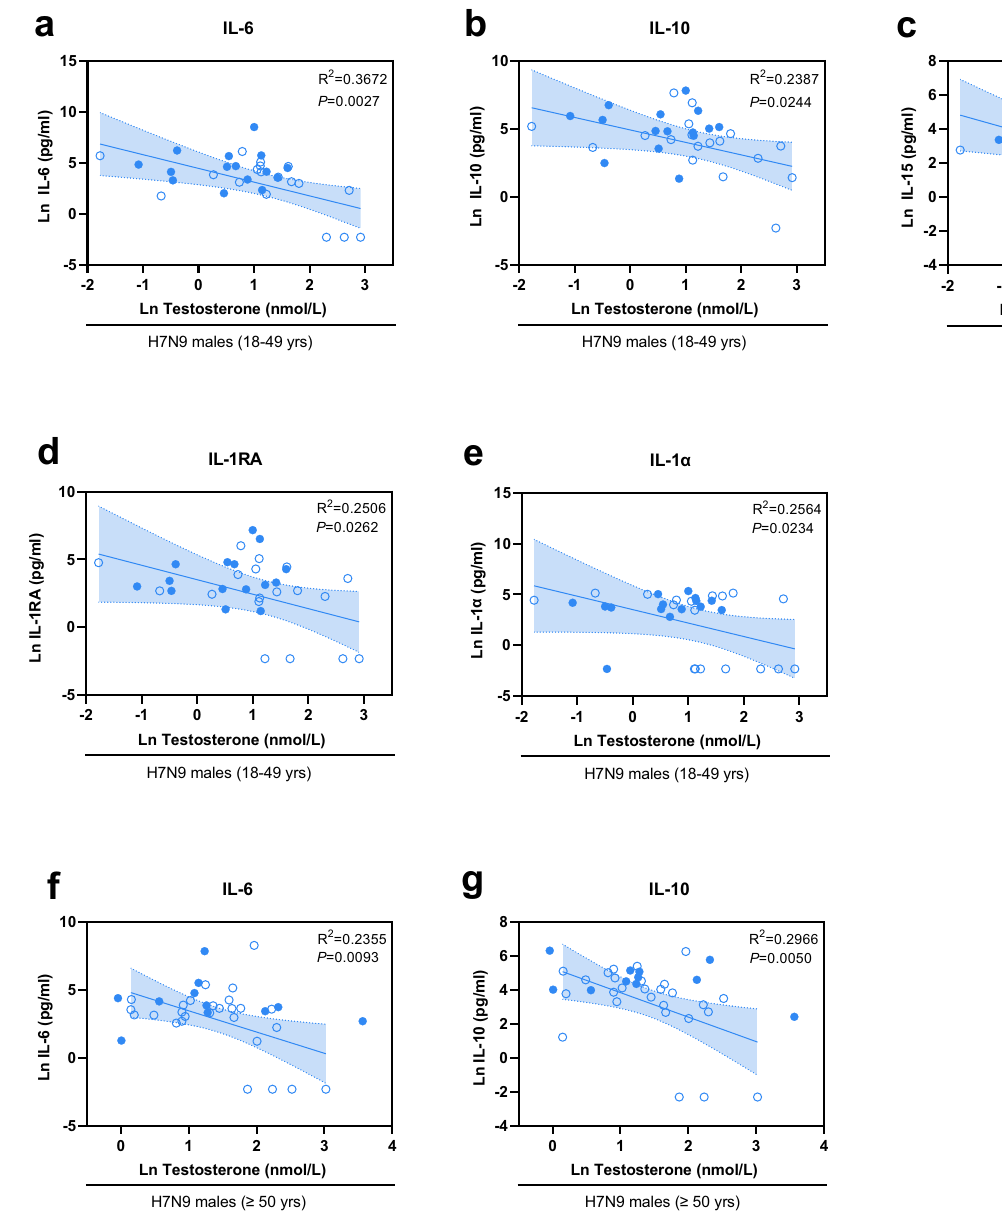
Fig. 5 | Correlation of testosterone and cytokine/chemokine levels in men infected with H7N9 in fl uenza. a – g Shown is the observed regression between testosterone and cytokine/chemokine levels in H7N9 IAV-infected males. Natural logarithm transformed (Ln) testosterone expression levels measured in the sera from H7N9 males were plotted over the Ln transformed cytokine/chemokines levels. a – e Overall regression of testosterone with cytokines IL-6 (interleukin 6; a ), IL-10 (interleukin 10; b ), IL-15 (interleukin 15; c ), IL-1RA (interleukin 1 receptor antagonist; d )andIL-1 α (interleukin1alpha; e )observedfromH7N9youngermales without interaction between deaths and survivors (18 – 49yrs survival/death: